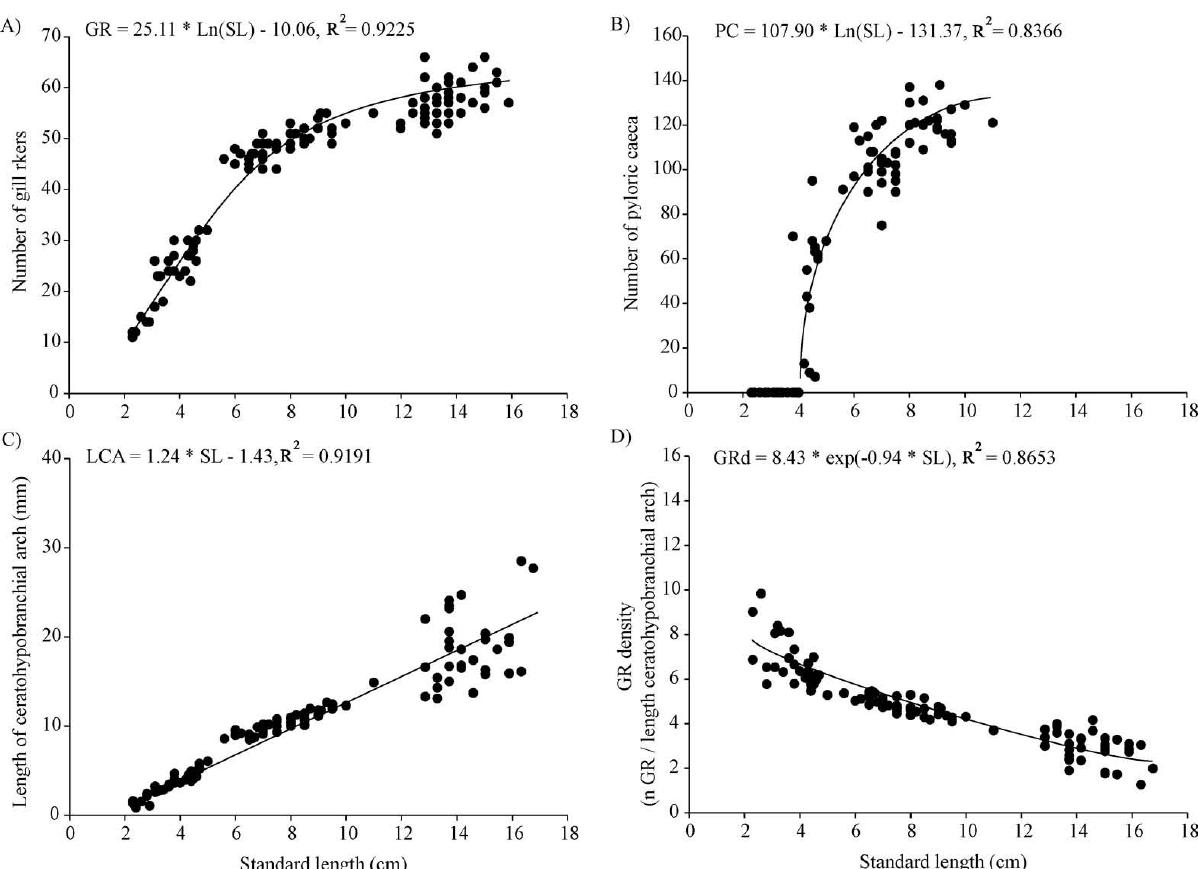
Fig. 3. – Relationships between standard length of sardine and different anatomical structures related to feeding. A, number of gill rakers GR; B, number of pyloric caeca PC; C, length of the ceratohypobranchial arch LCA (mm); D, density of gill rakers GRd (number of gill rakers / length of ceratohypobranchial